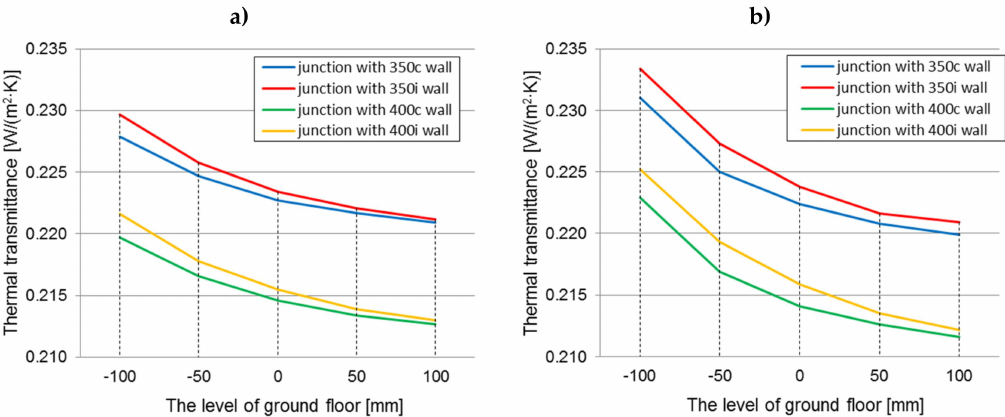
Figure 7. The averaged thermal transmittance of the ground junction in all construction variants of walls filled with hemp–lime composite ( λ = 0.080 W / (m · K)) depending on the floor level on the ground: ( a ) floor on joists; ( b ) self-supporting floor.